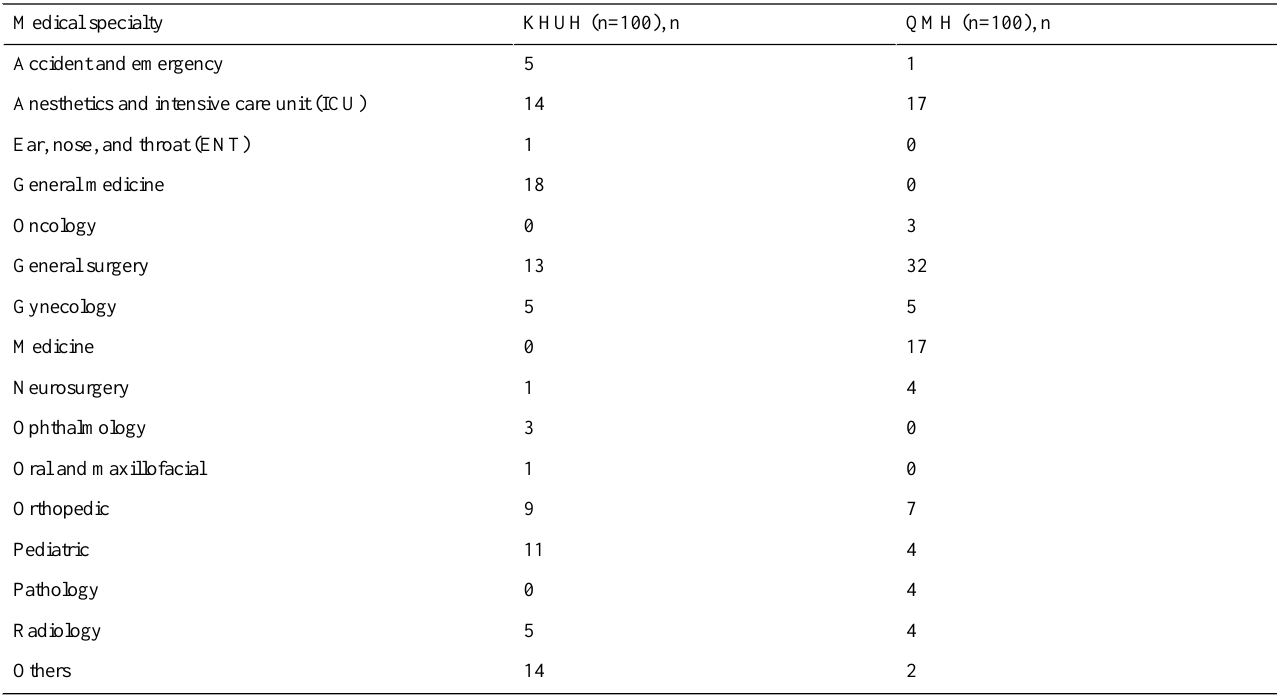
Table 1. Medical specialty of the participants in King Hamad University Hospital (KHUH) and Queen Mary Hospital (QMH).